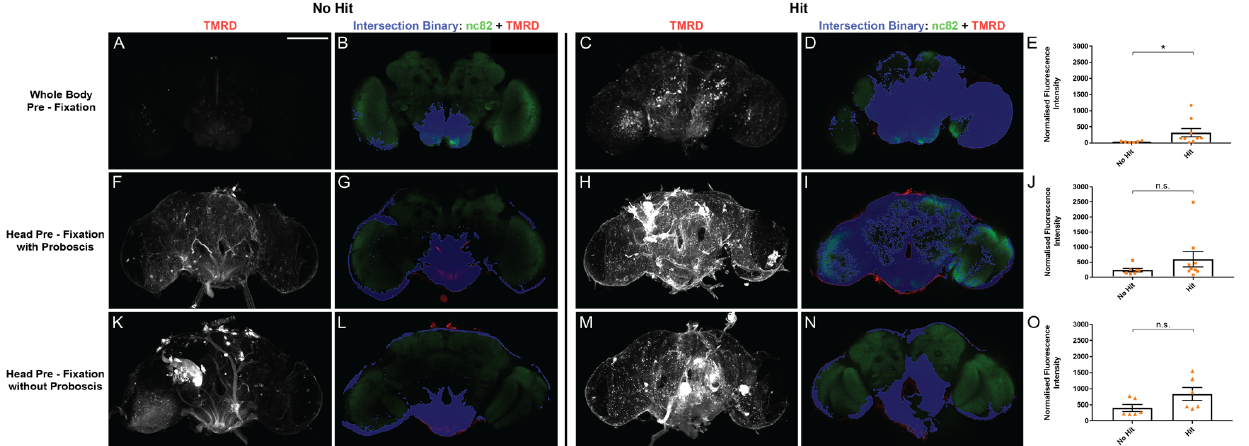
Figure 3. Whole-body pre-fixation reduces baseline TMRD fluorescence and reveals the effect of traumatic injury on dye infiltration. ( A , C , F , H , K , M ) Representative maximum projection laser-scanning confocal images of the TMRD channel and ( B , D , G , I , L , N ) single z-plane intersection binary of nc82 and TMRD signal, of whole-mount brains from d10 w 1118 females injected with TMRD on d9. Brains were processed for fixation by: ( A – D ) whole-body pre-fixation, ( F – I ) head pre-fixation with proboscis attached, ( K – N ) head pre-fixation without proboscis. Flies either did not experience a traumatic injury (No Hit) or were exposed to traumatic injury 2 h after dye injection (Hit). ( E , J , O ) Quantification of normalized TMRD fluorescence infiltration across fixation conditions using nc82/TMRD intersection binary analysis. * p < 0.05; n.s. = not significant. Mann–Whitney U-test ( E , J ), t -test ( O ); n = 6–9. Error bars are presented as mean ± SEM. Scale bar = 100 µm.